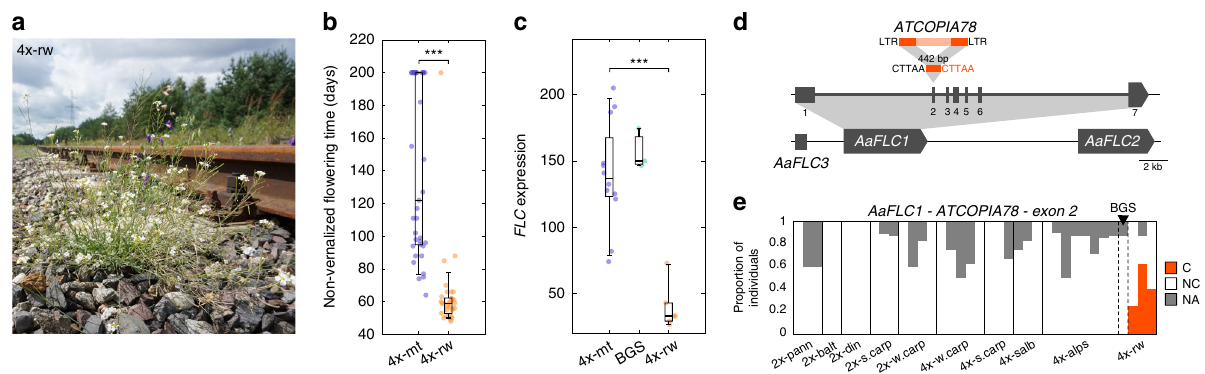
Fig. 5 Railway-speci fi c ATCOPIA78 solo-LTR exonic insertion within FLC . a Picture of a tetraploid A. arenosa individual growing on railway ballasts near Ś winouj ś cie, Poland, in July 2017. b Non-vernalized fl owering time, measured in days to the fi rst open fl ower, of mountain (4x-mt) and railway (4x-rw) tetraploid populations. Data was redrawn from Baduel et al. 20 . Boxplot center lines, median; box limits, upper and lower quartiles; whiskers, 9th and 91st quantiles. c FLC expression tetraploid populations from mountain (4x-mt) and railway (4x-rw) and the hybrid mountain-railway population BGS. Data were redrawn from Baduel et al. 35 . Boxplot center lines, median; box limits, upper and lower quartiles; whiskers, 9th and 91st quantiles. d Map of FLC region with 442bp-long ATCOPIA78 solo-LTR insertion in 2nd exon of AaFLC1 identi fi ed by fosmid sequencing. e Proportion of individuals across populations by clade (pann pannonian, balt baltic, din = dinaric, s.carp = south-carpathians, w.carp = west carpathians, salb = swabian alb, rw = railway) carrying (C) or not- carrying (NC) the ATCOPIA78 solo-LTR insertion or not-assigned (NA). Hybrid mountain-railway population BGS is indicated with black triangle. The source data underlying Fig. 5e are provided as a Source Data fi